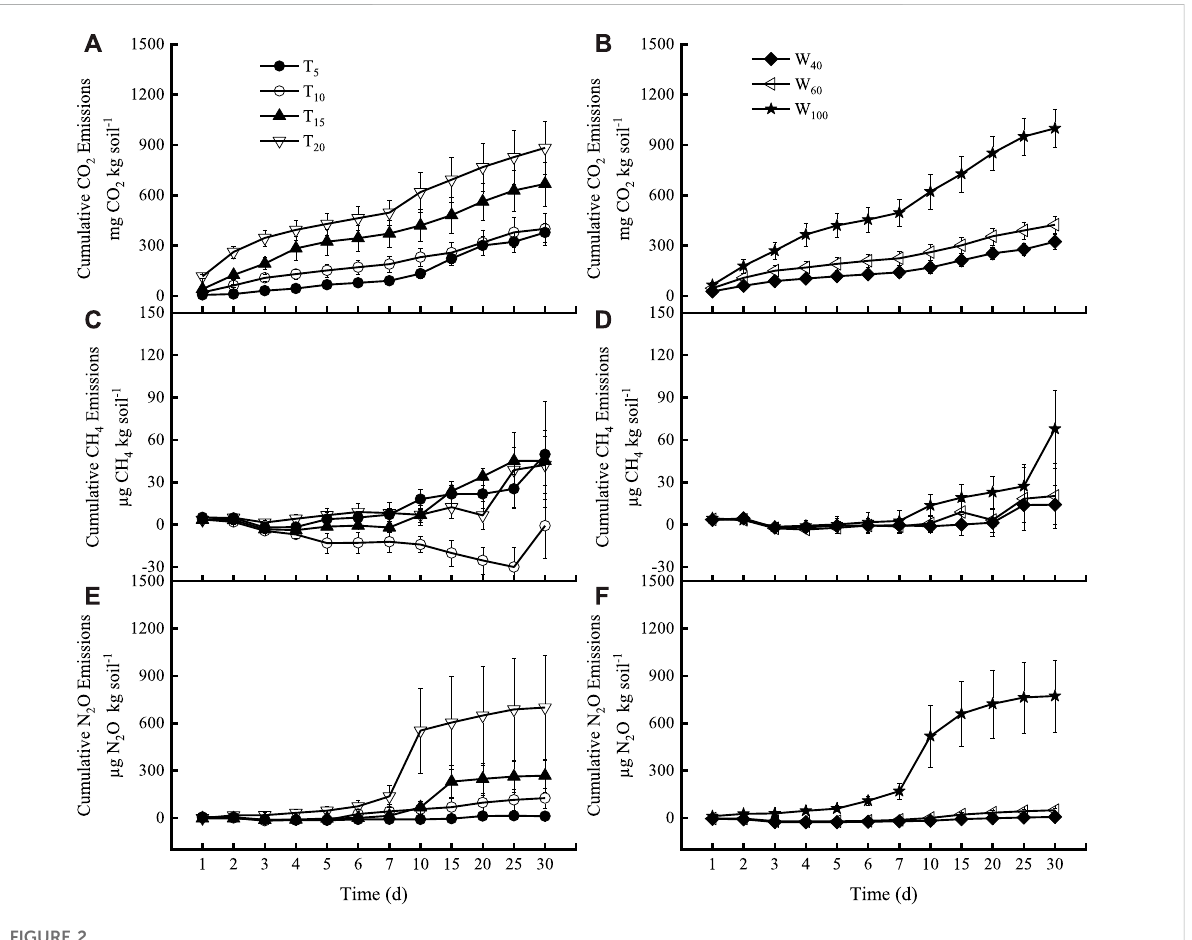
FIGURE 2 TemporalchangesinsoilcumulativeCO 2 ,CH 4 andN 2 Oemissions.Theerrorbarsshowstandarderrors: n =9and12fortemperatureandWHC,